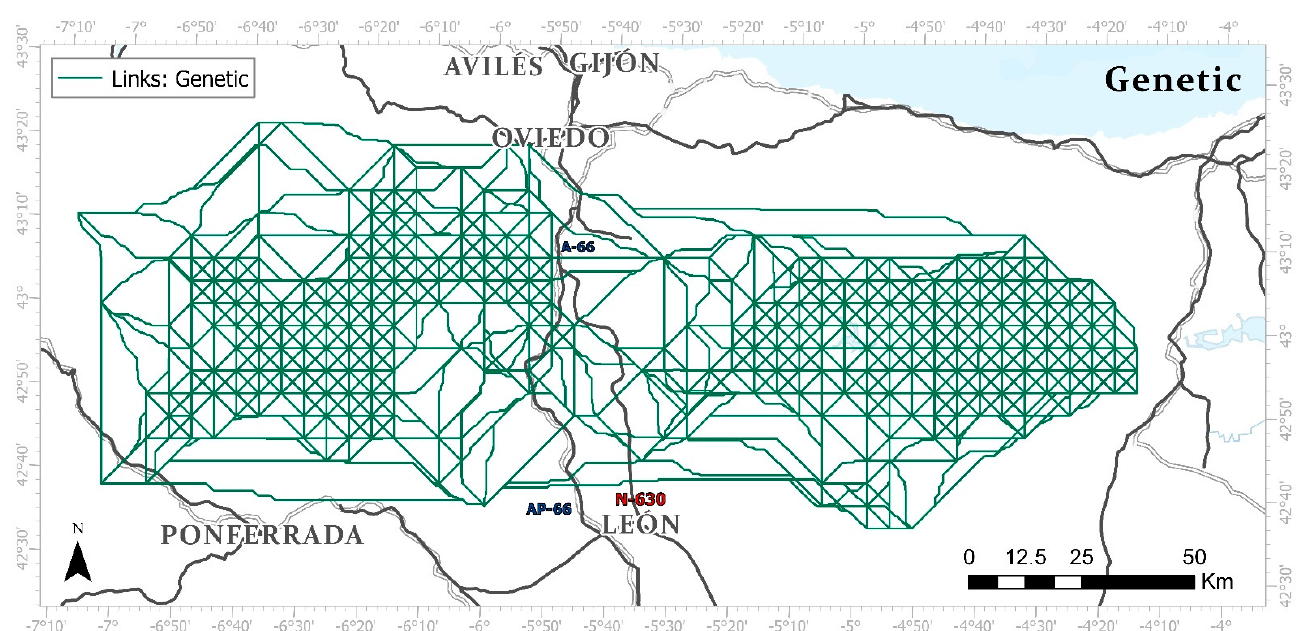
Figure A3. Operational scales of the ruggedness, buildings, highways and roads variable, which are common for the three datasets.